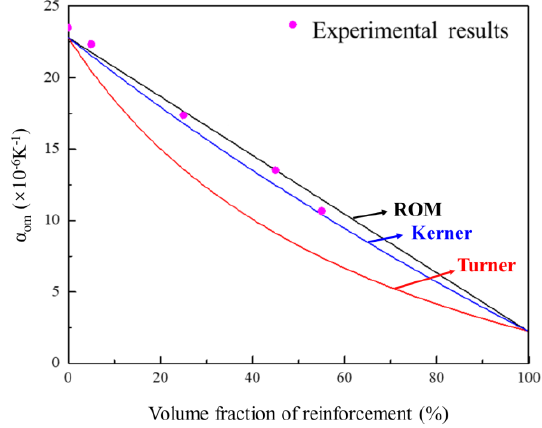
Figure 10. Hardness of AlN/Al gradient composite with different volume fractions.